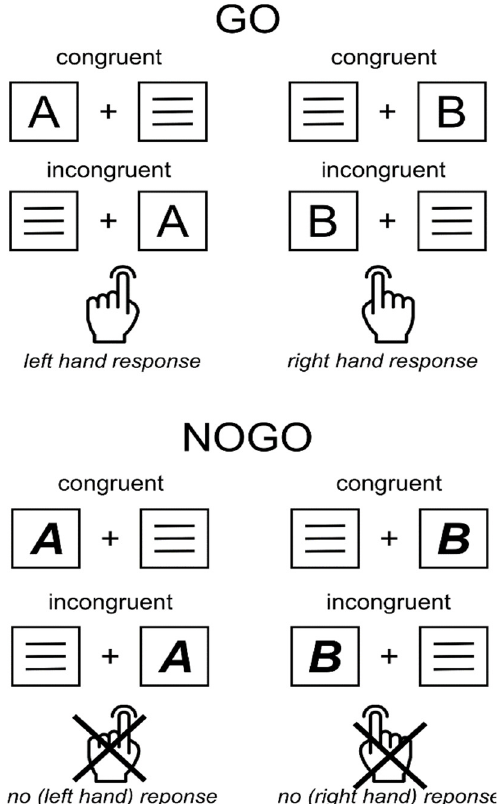
Figure 1. Experimental Simon Nogo paradigm. All possible stimulus-response combinations are illustrated for the Go condition ( top panel ) and the Nogo condition ( bottom panel ). Participants were comfortably seated in front of a 24” CRT monitor at a distance of 57 cm. A white central fixation cross was continuously presented in the center of the screen and sided by two lateralized white frame boxes against a black background. This visual setup was constantly displayed for the entire duration of the task. On each trial, a single yellow letter stimulus in a standard “Arial” font (i.e., letter “A” or “B”) was displayed for 200 ms within either the left or the right white frame box. At the same time, a